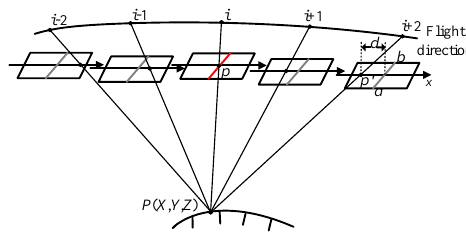
Figure 6. Best scan line searching for pushbroom image.